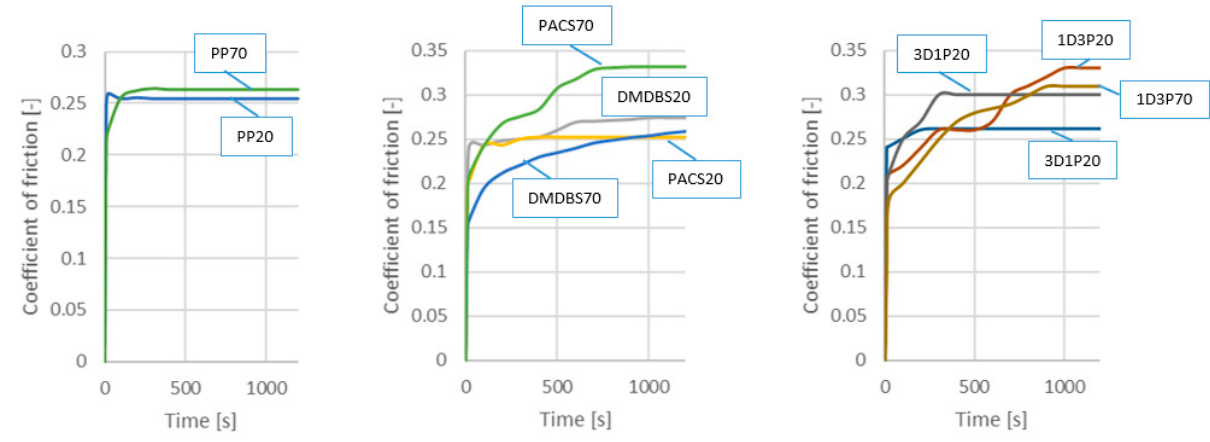
Figure 5. The coefficient of friction as a function of the sliding distance for the samples 20 °C and 70 °C for the normal load of 25 N.